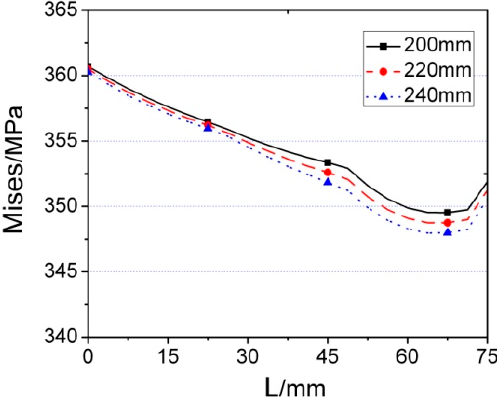
Figure 23. The Von Mises stress distributions along beam length (starting from steel tube) of RD series FE joint models.